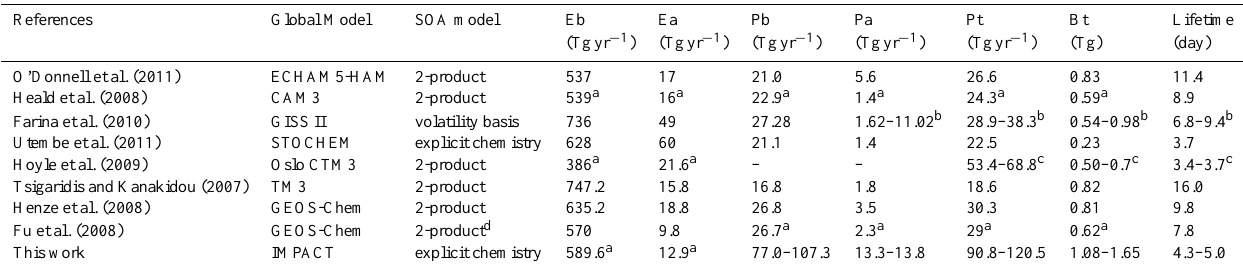
Table 5. Global modeling studies of SOA precursor emissions, SOA production, burden and lifetime (Eb: emissions of biogenic species (i.e., isoprene and monoterpenes); Ea: emissions of anthropogenic species (i.e., aromatics); Pb: SOA production from biogenic species; Pa: SOA production from anthropogenic species; Pt and Bt: total SOA production and SOA